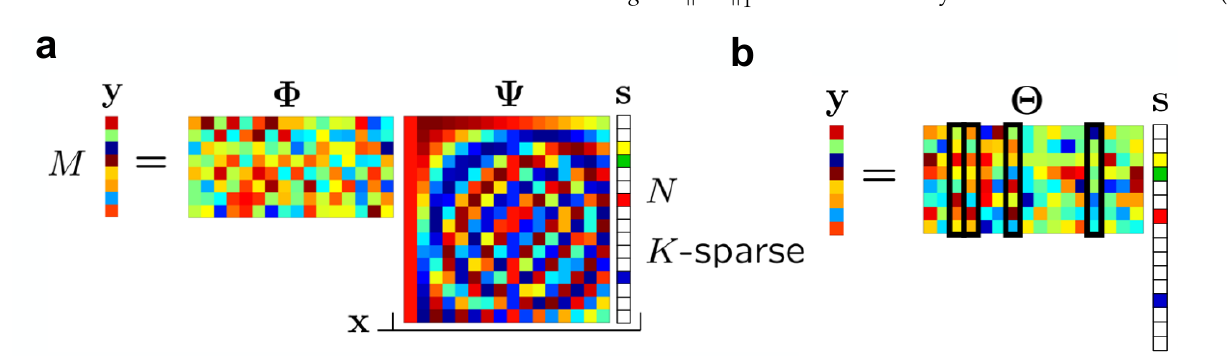
Figure 8. The compressed sensing processes. ( a ) Compressed sensing measurement process with measurement matrix Φ and discrete cosine transform (DCT) matrix Ψ . ( b ) The matrix product Θ = ΦΨ with the four columns corresponding to nonzero S i highlighted. Reproduced with permission [4] Copyright 2007,